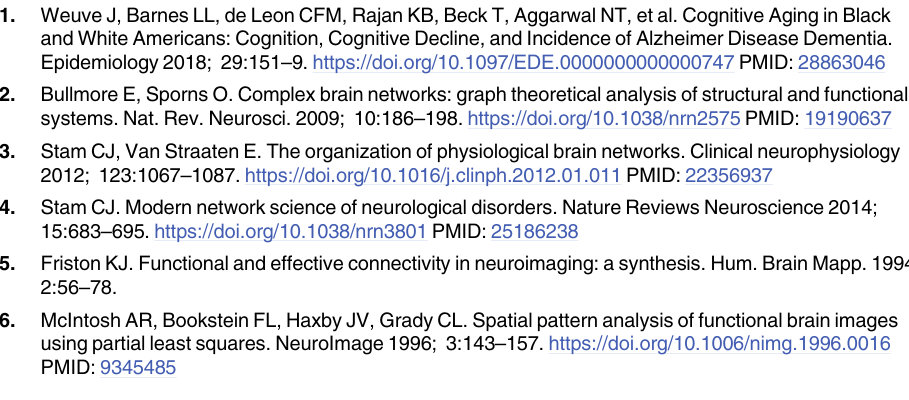
S1 Table. Spearman’s correlations in all 40